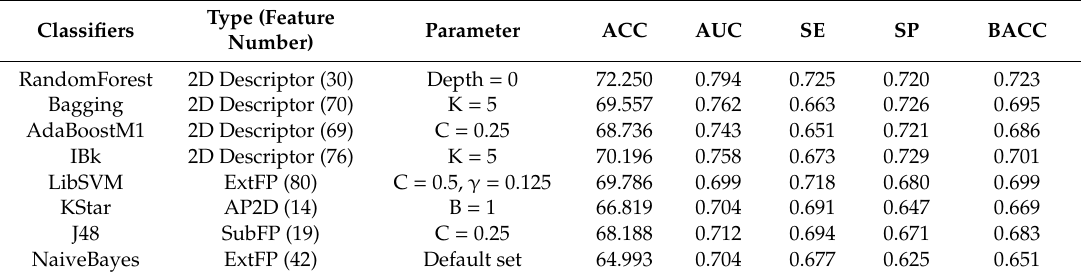
Table 3. Performance of the eight best single classifiers.